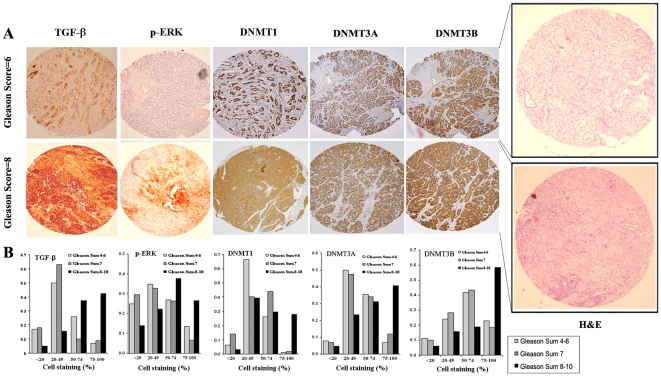
Confirmation of p-ERK mediated, TGF-β-induced DNMT in TMA specimens obtained at the time of prostatectomy.
A. Immunohistochemical analysis of serial TMA sections from a patient with Gleason's score of 8, revealed higher expression of TGF-β, p-ERK, DNMTs, but lower expression of TβRI and TβRII and p-Smad2 as compared to serial sections taken from a patient with a lower Gleason's grade of 6. These results are representative of the predominant staining pattern seen in all patient samples/tissue arrays (magnification: 10×20). The corresponding frequency (or percentage) of staining and intensity of staining could be found on B. B. High levels of TGF-β1 expression (Score = 3) were identified in 42.3%, 8.9% and 7.0%, p-Erk expression in 36.4%, 6.7% and 13.5%, DNMT1 expression in 27.9%, 1.8% and 1.3%, DNMT3A expression in 40.6%, 11.9% and 6.7%, and DNMT3B expression in 58.7%, 18.3% and 22.8% of high (≥8), intermediate ( = 7), and low Gleason grade (≤6), respectively.